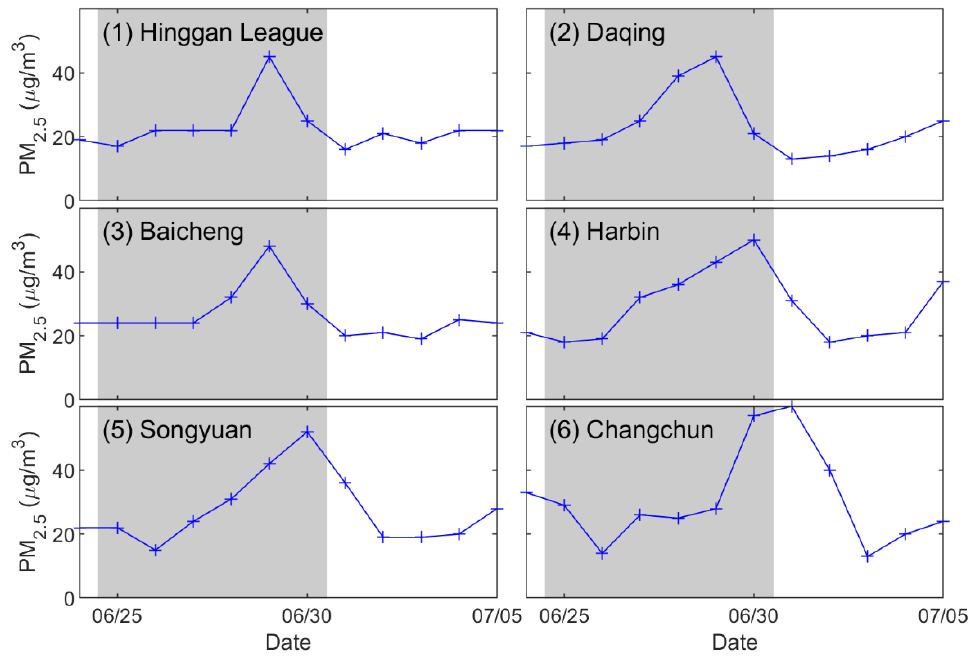
Figure 10. Daily average PM 2.5 concentration (unit: µ g · m − 3 ) at the six stations in Northeast China. The biomass burning episode is represented by the grey box.